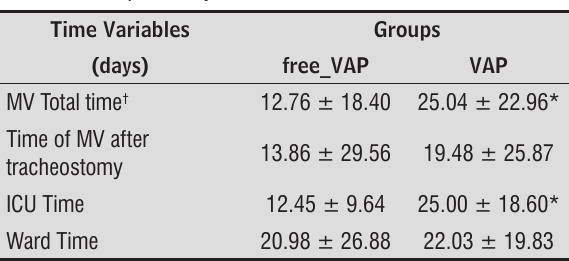
Figure 1 - Number of deaths verified in the Intensive Care